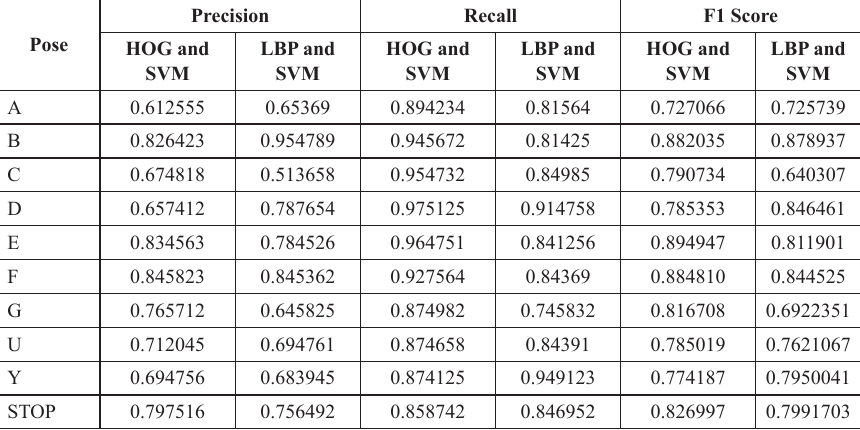
Table 4. Recall and F1 score between our system and system in